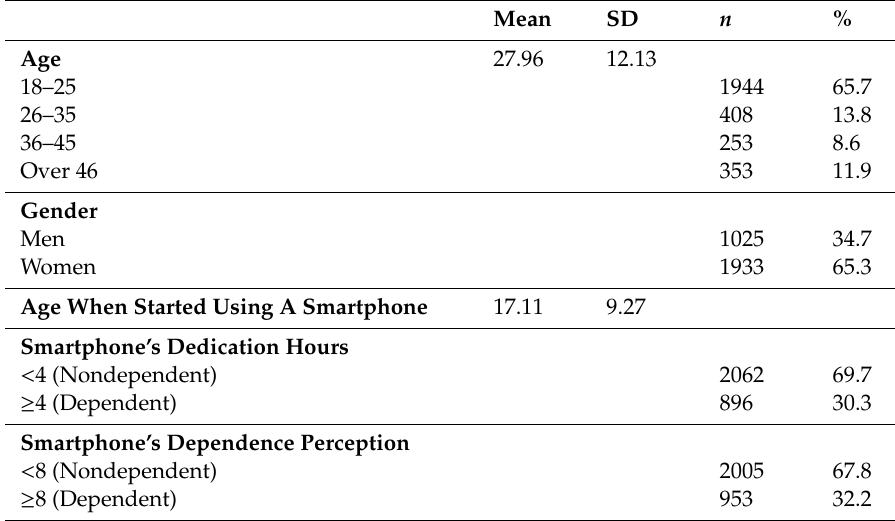
Table 1. Characteristics of the studied population.